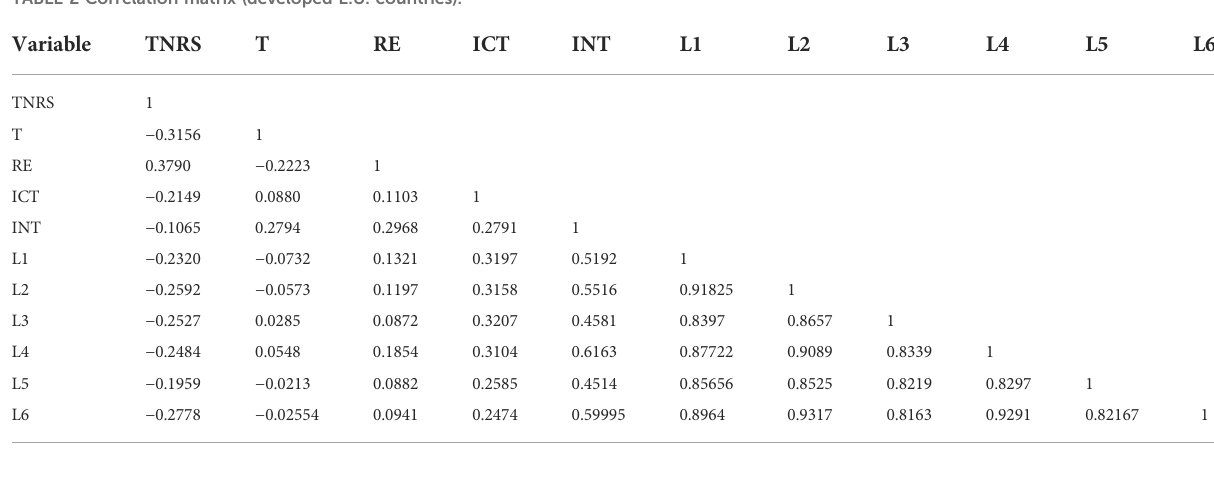
TABLE 2 Correlation matrix (developed E.U. countries).